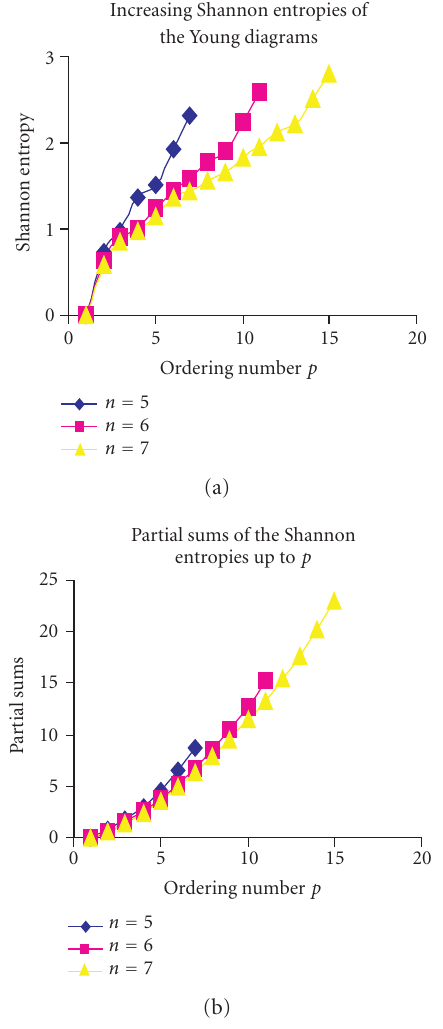
Figure 4.7. Progression of di ff usion process: (a) Shannon entropies of the Young diagrams as a function of the ordering number p according to (4.4), (b) partial sums of Shannon entropies up to p as a function of p